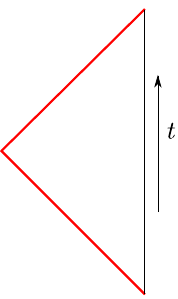
Figure 4 . An alternative to our proposal: typical states have a (cid:12)rewall on the horizon. This would be consistent with the Killing isometry, but would correspond to modi(cid:12)cations of general relativity at low